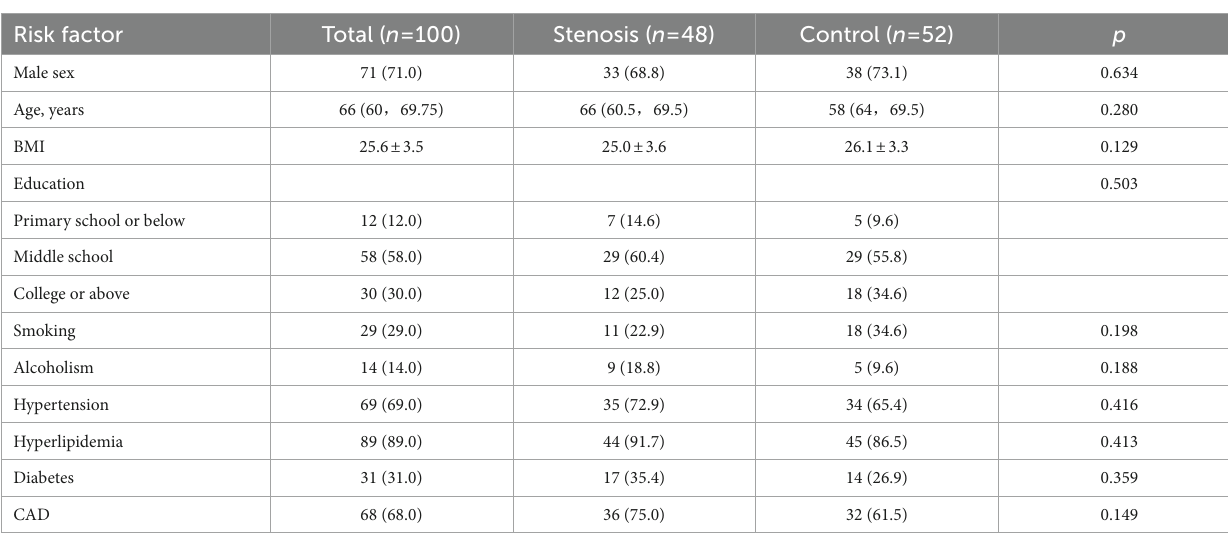
TABLE 1 Baseline clinical characteristics of